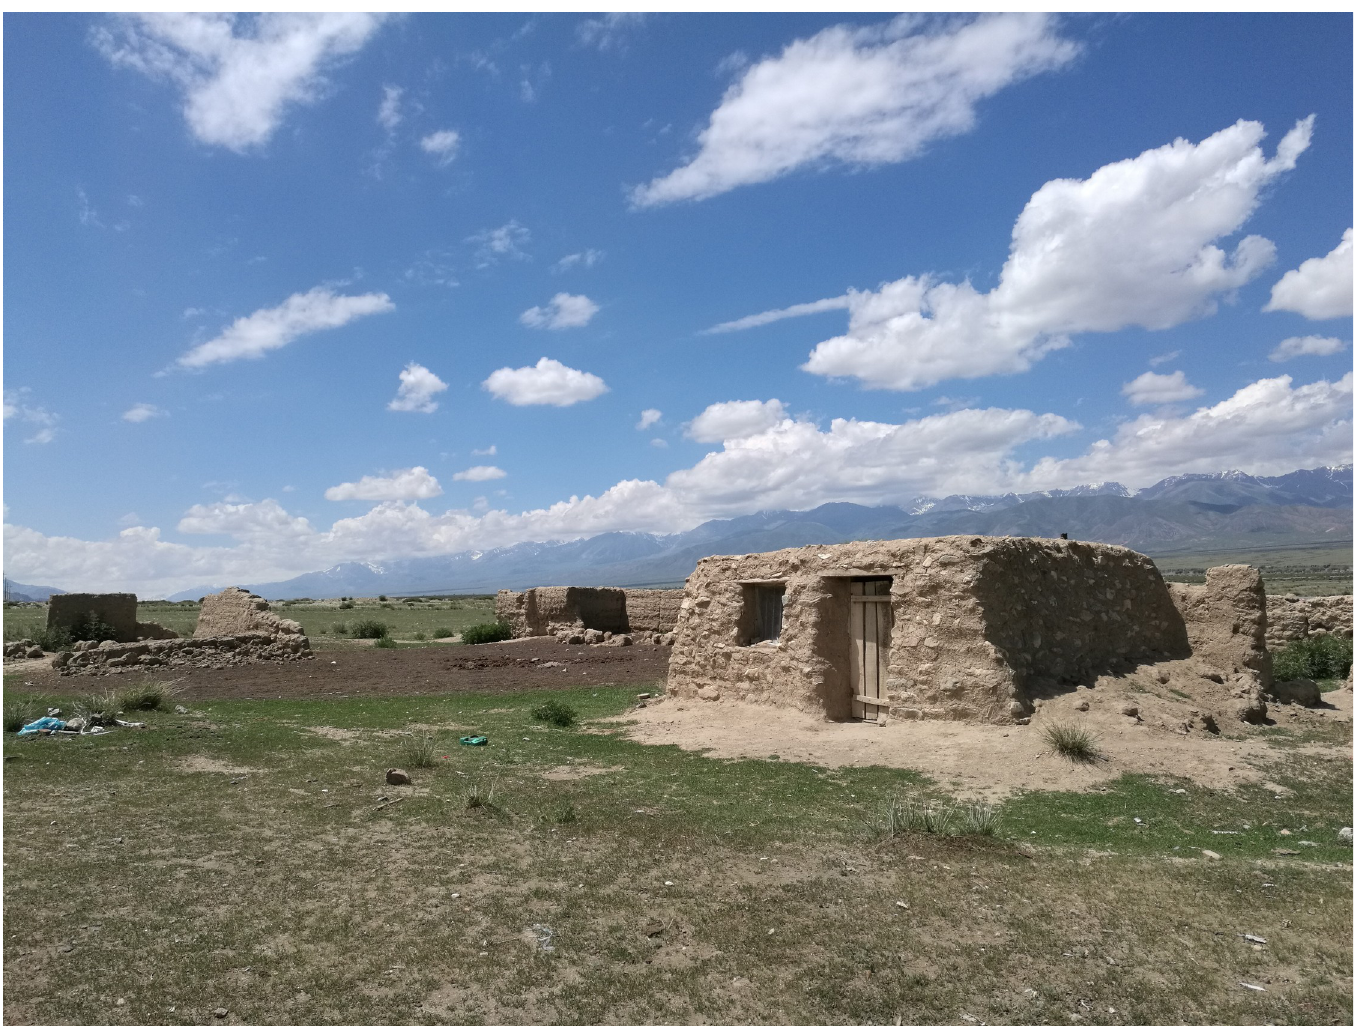
Fig 8. Traditional spring/autumn campsite for local herders. The site was abandoned after the herders moved to a newly constructed government funded house with an animal fold in a permanently settled village (P.